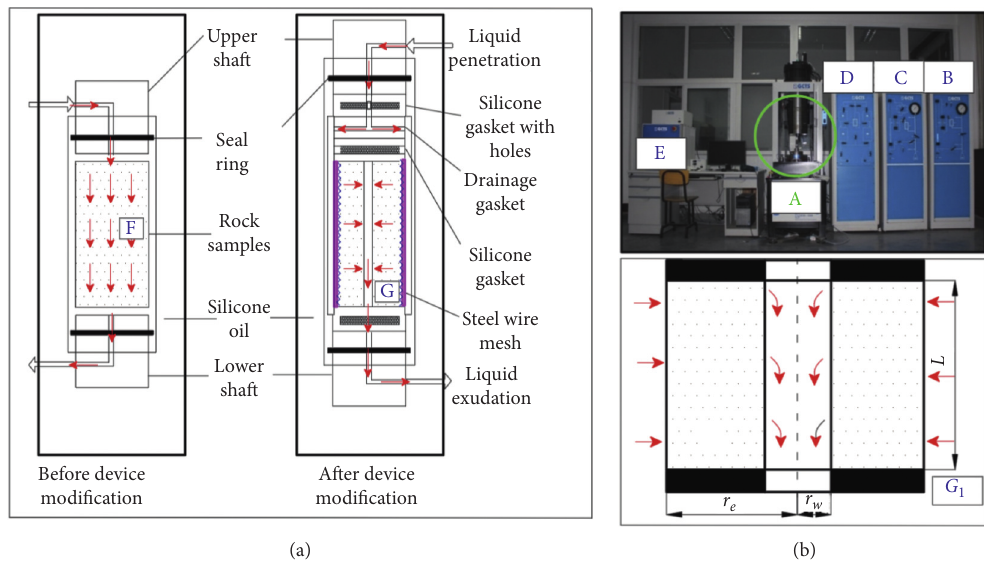
Figure 1: Comparison of flow paths before and after improvement of the RTR-1000 seepage test system. A: penetration test system; B: hole pressure supercharger; C: confining pressure supercharger; D: permeameter; E: console; F: traditional rock specimen; G: hollow cylinder rock specimen; G 1 : profile of hollow cylinder rock specimen with seal